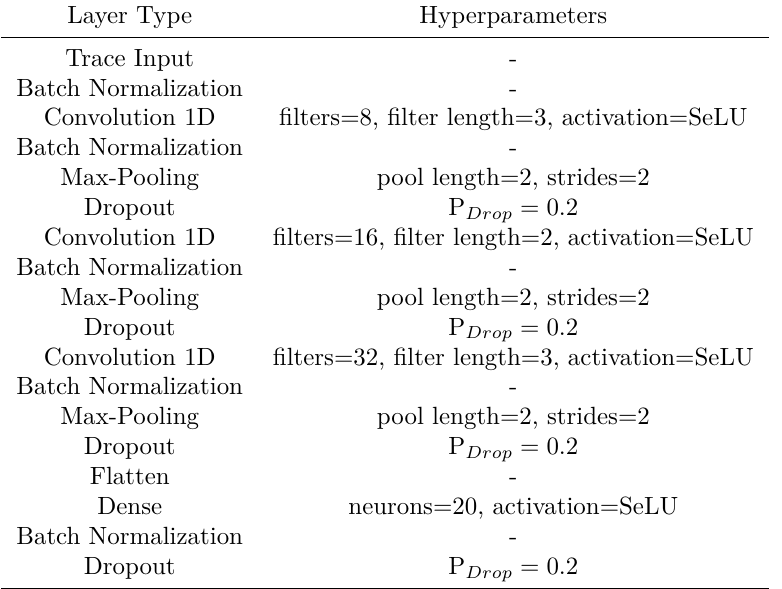
Table 4: Network configuration of CNN